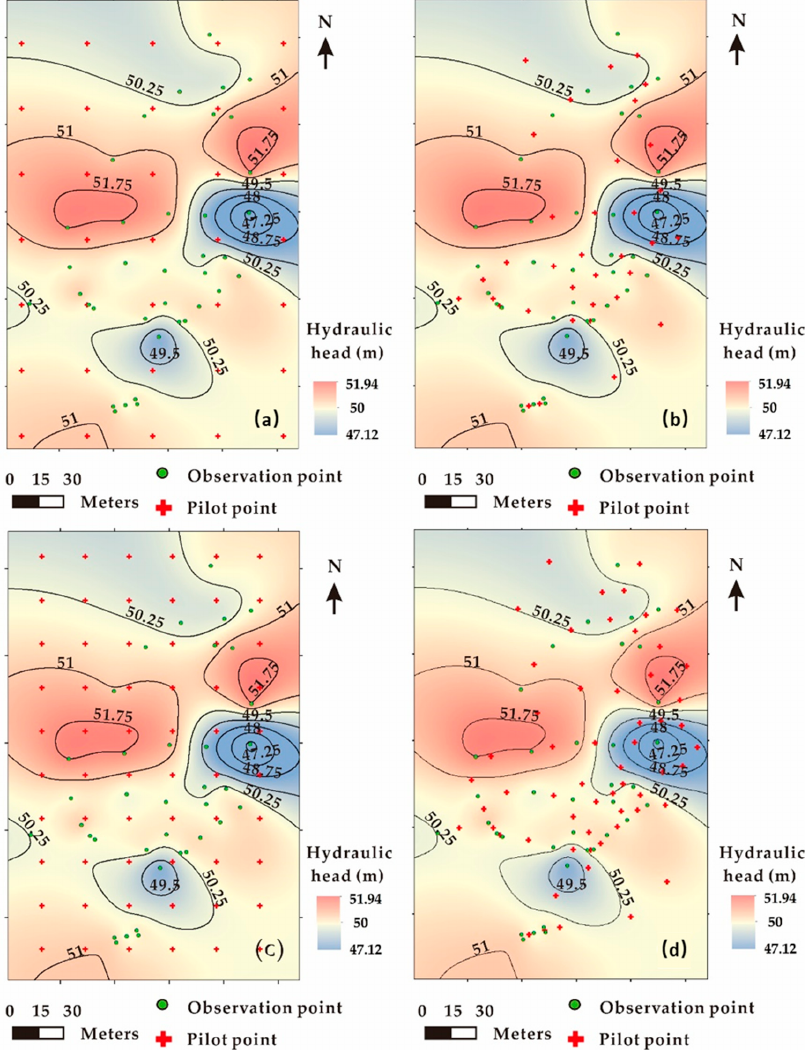
Figure 4. Pilot points placement design: ( a ) regular placement with 35 pilot points; ( b ) MHMDG placement with 35 pilot points; ( c ) regular placement with 60 pilot points; ( d ) MHMDG placement with 60 pilot points.